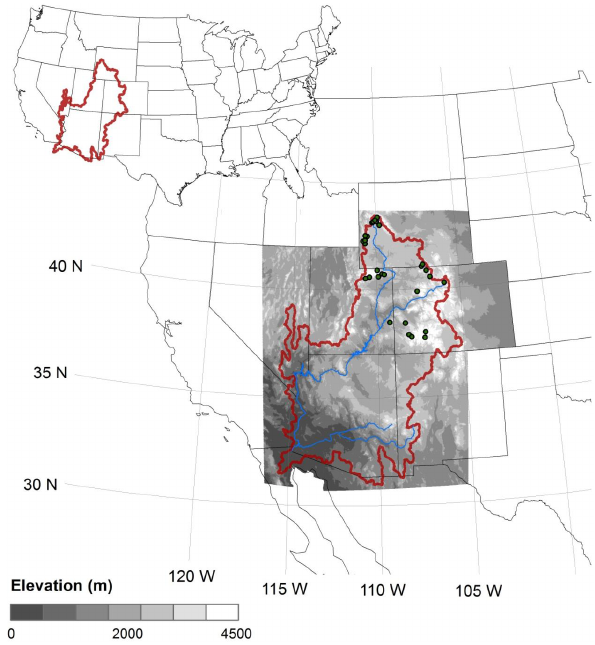
Fig. 1. A shaded relief map of the study area and locations of the SNOTEL sites with an outline of the Colorado Basin and western US